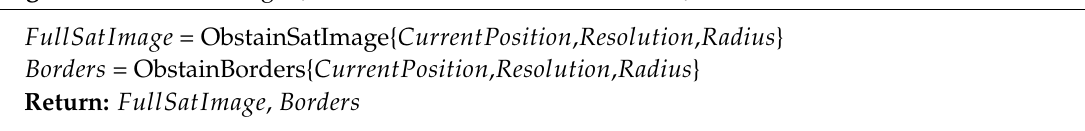
Algorithm 1 ObtainImages{ CurrentPosition , Resolution , Radius }